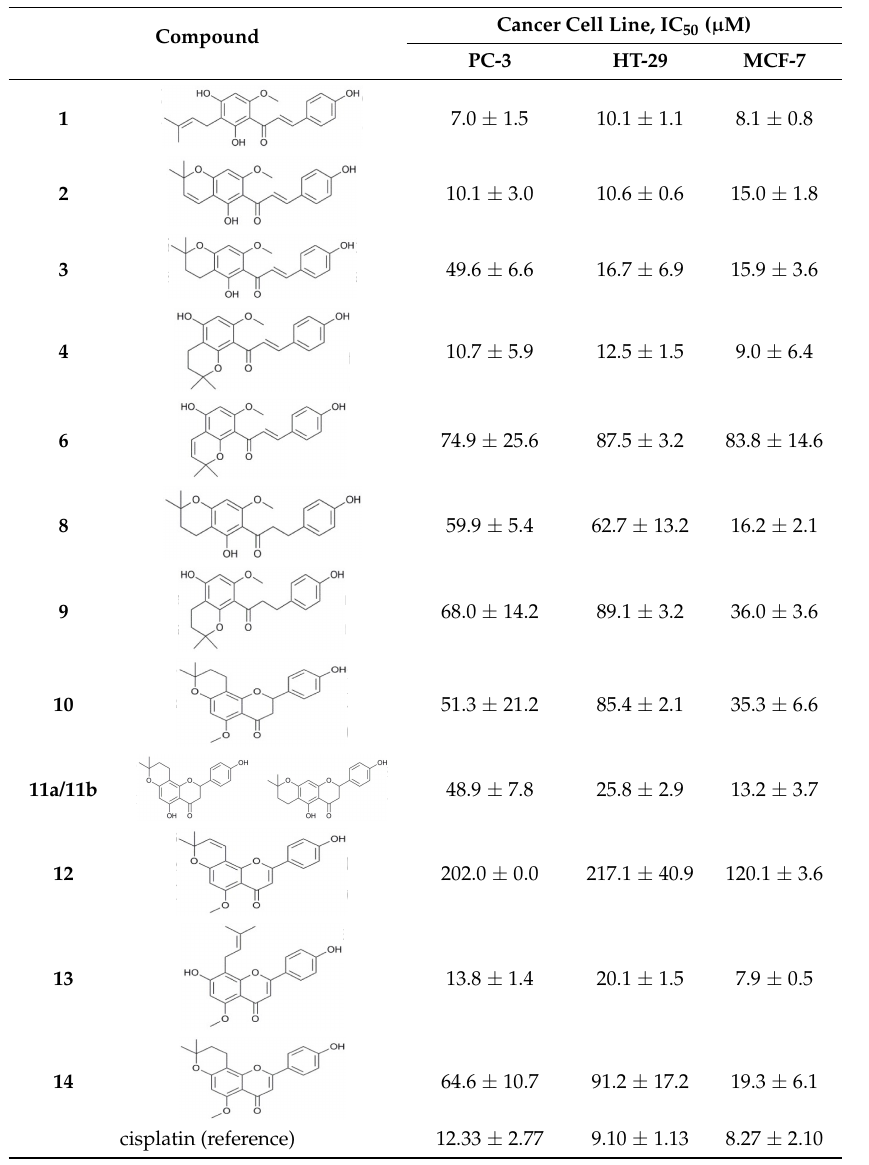
Table 2. In vitro antiproliferative activity of xanthohumol ( 1 ) and synthetized compounds against human cancer cell